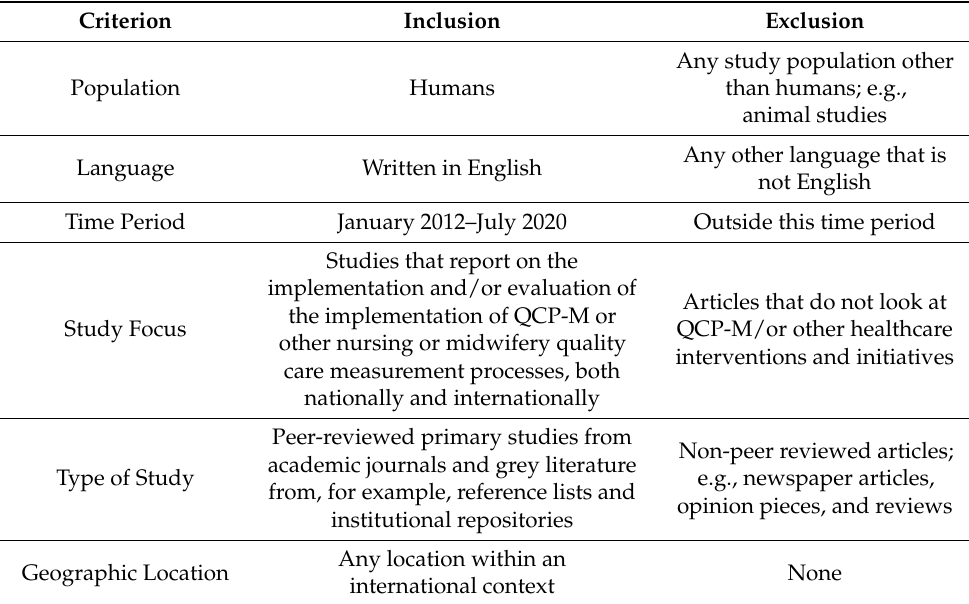
Table 1. The inclusion and exclusion criteria applied.